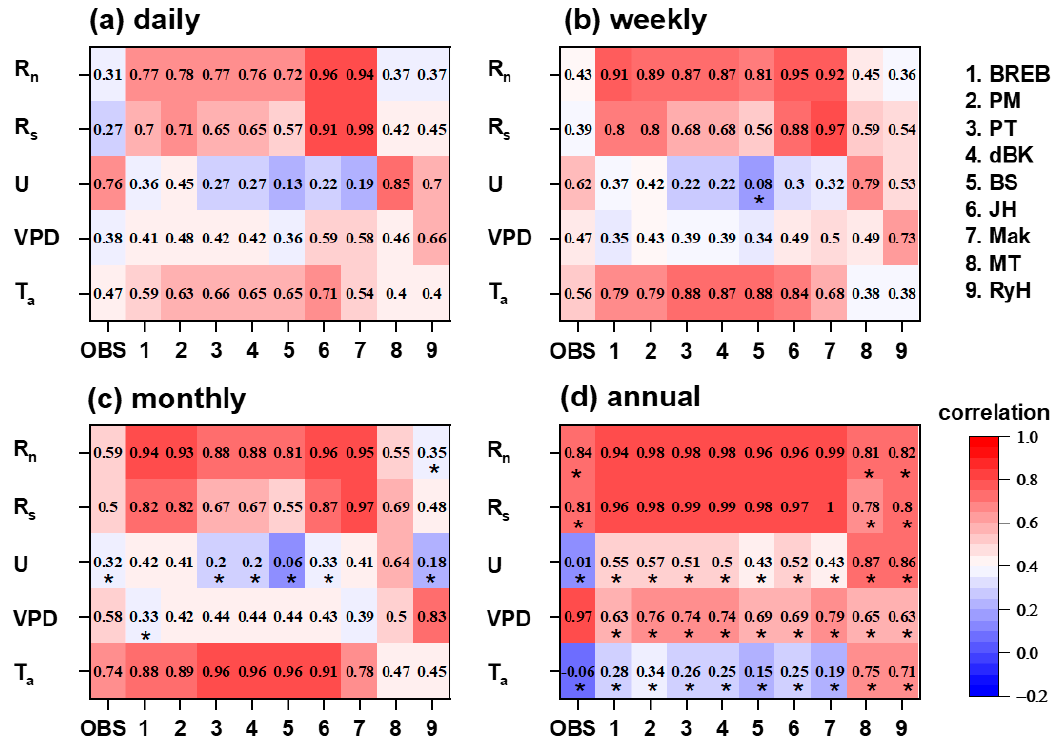
Figure 6. Correlations between evaporation and meteorological variables at ( a ) daily, ( b ) weekly, ( c ) monthly, and ( d ) annual timescale during 2015–2018. Lake evaporation is obtained from observations (OBS) and estimation of default evaporation methods. The asterisk * means the correlation is not significant at the 0.05 confidence level by the Student’s t